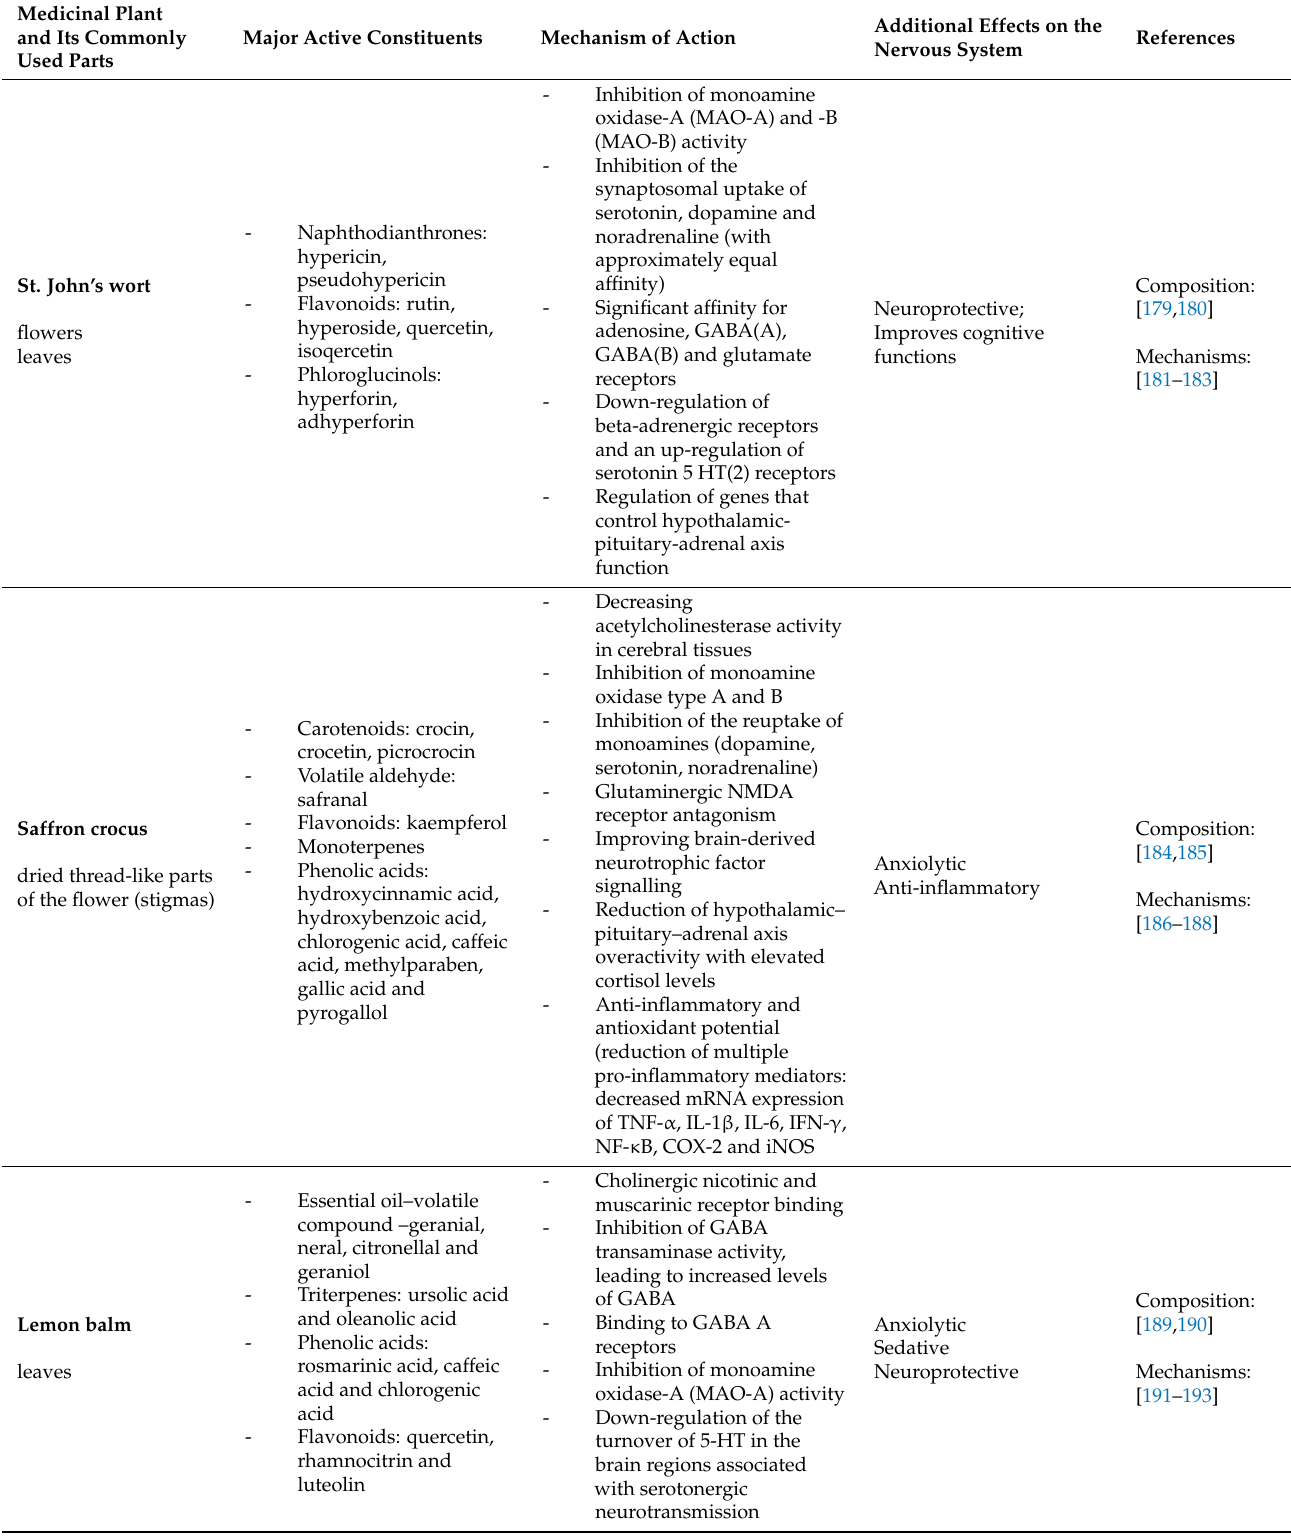
Table 4. Herbal antidepressants and their mechanisms of action